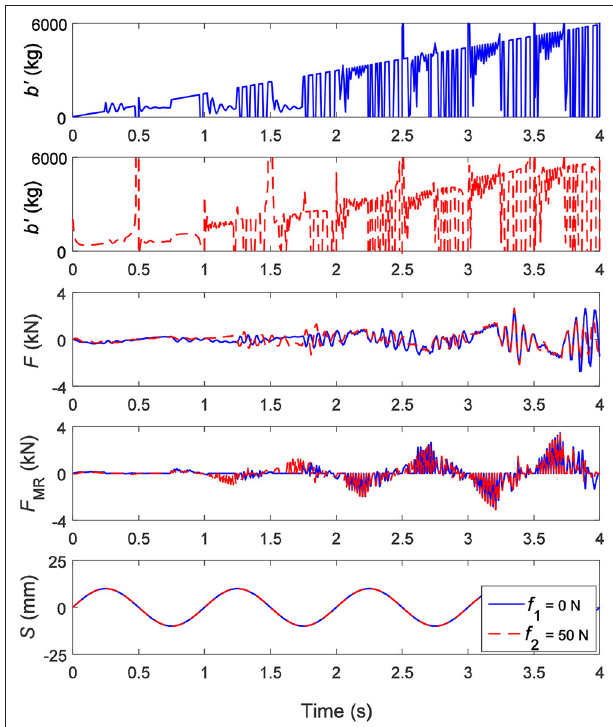
FIGURE 9 | The equivalent inertance b ′ , the output force F , the controllable force F MR under a sinusoidal displacement excitation S with an amplitude of 20mm and a frequency of 1.0Hz when the expected inertance is from 0kg to 6,000kg.